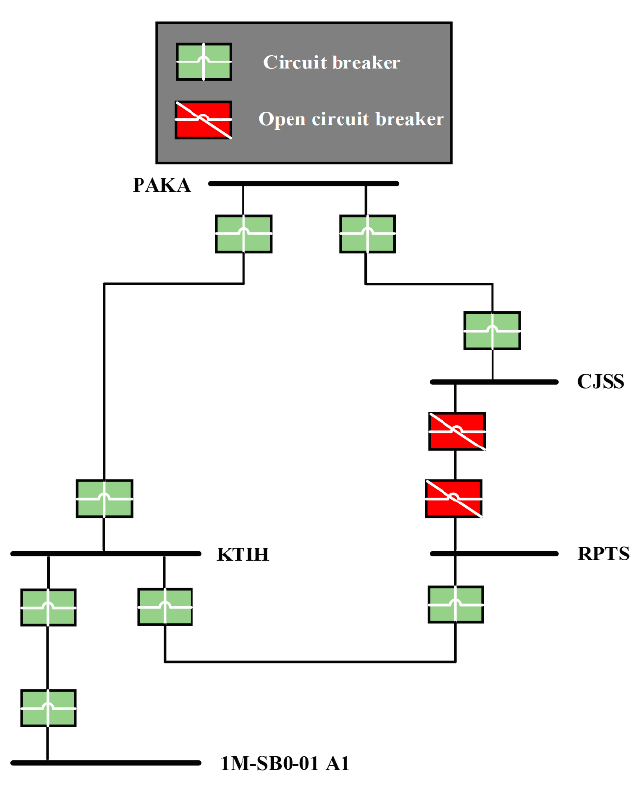
Figure 4. Islanding Scenario 2 of the test system.